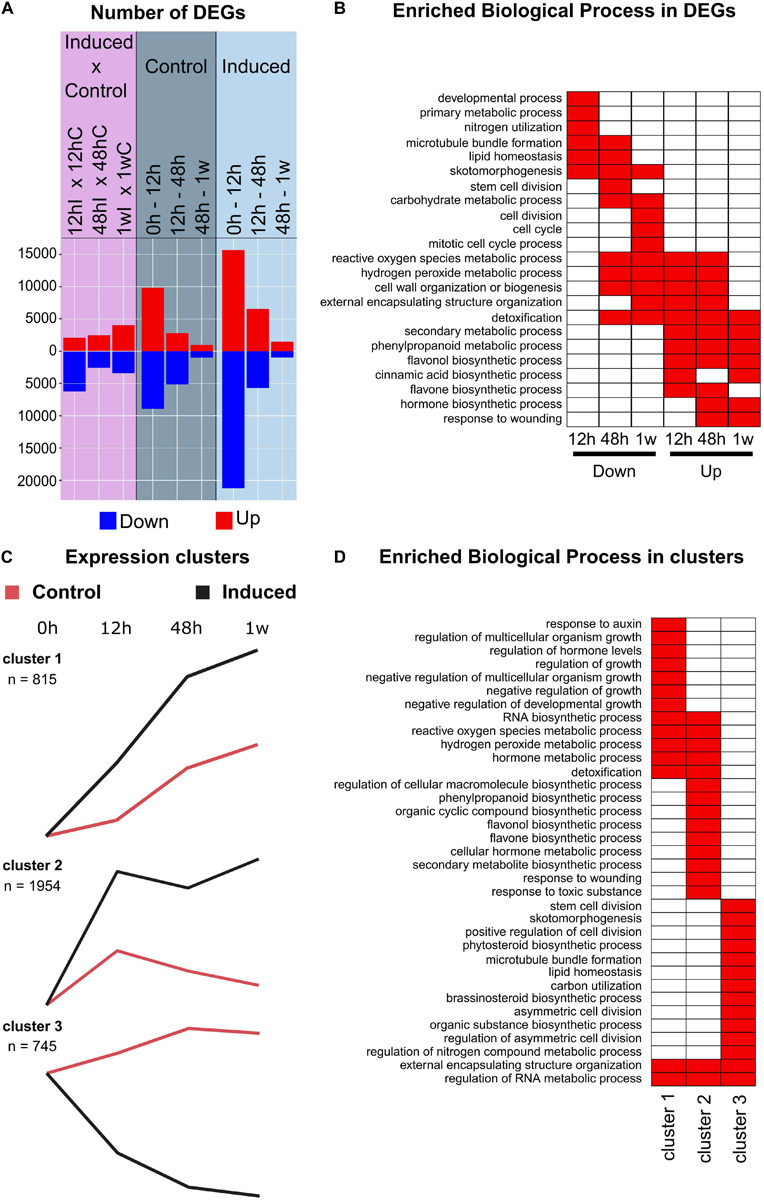
Large-scale transcriptomic analysis of the sugarcane cell cultures. (A) Double-sided histograms of the number of differentially expressed genes (DEGs) identified along the time course in control (dark blue shading) and induced (light blue shading) cells, separately, and between control and induced cells in each time point (pink shading). Up- and downregulation is indicated by red and blue color, respectively. (B) Enrichment analysis of biological processes terms from Gene Ontology among downregulated and upregulated DEGs found for the comparison control × induced samples for each time point [pink shading in (A)]. Enriched biological processes (P < 0.0001) in each sample are indicated by red boxes. For brevity, only 23 GO terms are shown. (C) Selected clusters/modules whose expression shows distinct patterns between induced and control samples along the time course. Line graphs denote the average of the module eigengene expression, which is the most representative gene expression profile of the module. Average expression of induced and control samples is shown in black and red, respectively. (D) Enrichment analysis of biological processes terms from Gene Ontology among genes associated with selected clusters [shown in (C)]. Enriched biological processes (P < 0.0001) in each cluster are indicated by red boxes. For brevity, only 35 GO terms are shown.